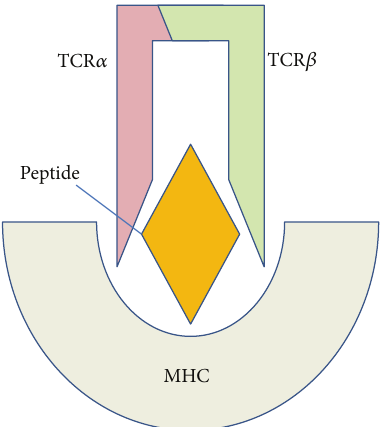
Figure 1: The trimolecular TCR-pMHC complex that is fundamen- tal in T1D susceptibility.